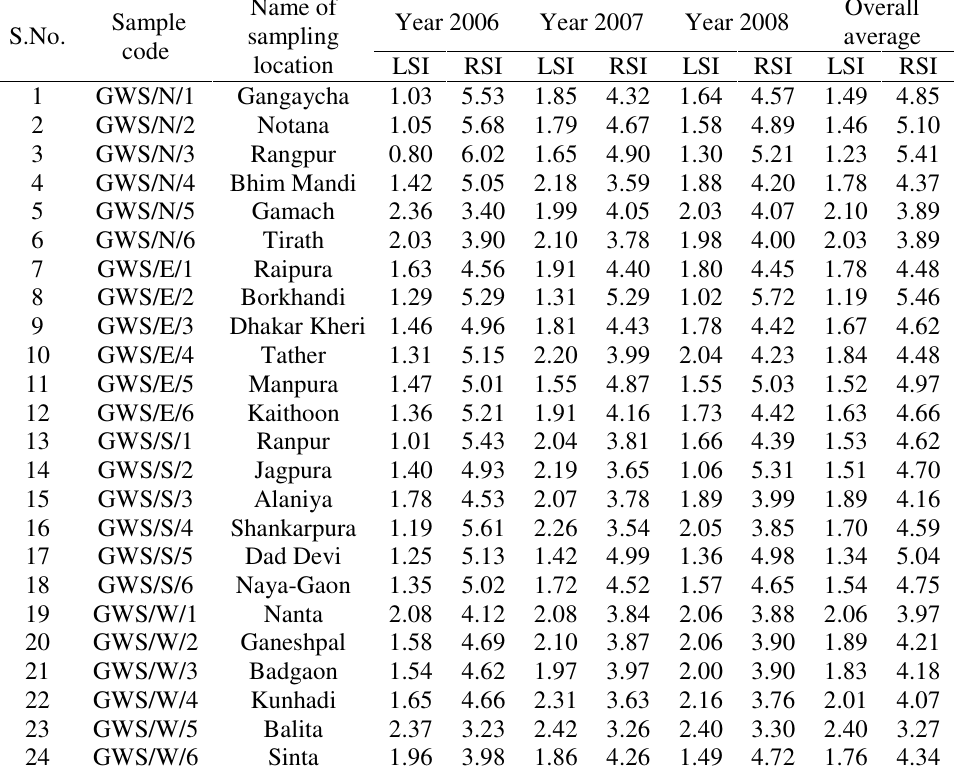
Table 3. Calculated Indices of groundwater samples collected from outer skirts of Kota City (Indices are calculated from average values of the respective year)